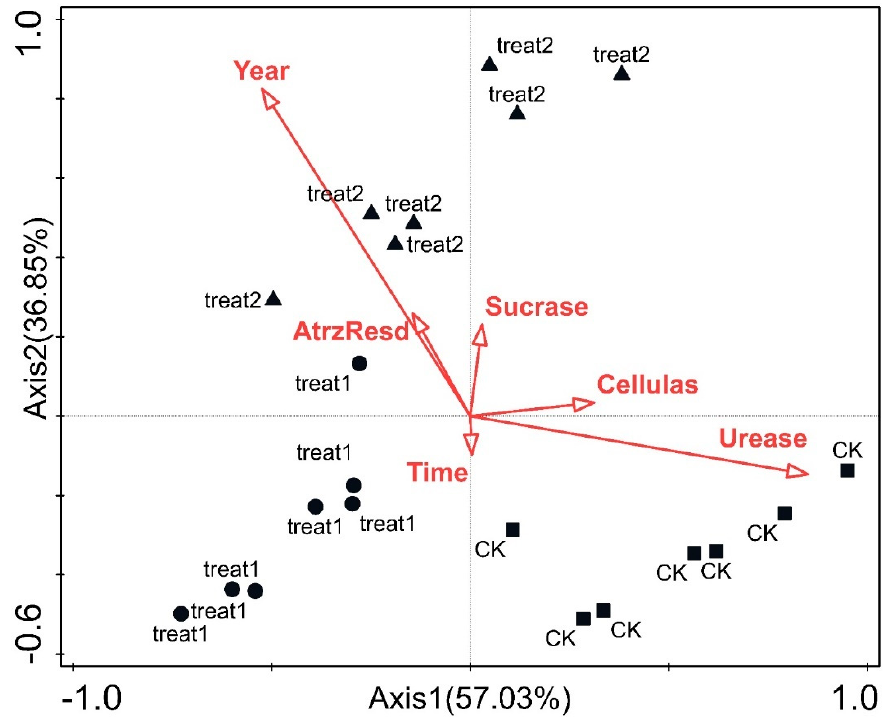
Figure 6. Soil PLFAs under different atrazine application treatments. Data represent the mean ± SD of each soil sample selected at each time-point. ( A ) Gram-positive bacterium (G+); ( B ) Gram-negative bacterium (G-); ( C ) bacterial; ( D ) fungal. Figure 8. Redundancy analysis (RDA) of the PLFA data as explained by environmental variables.